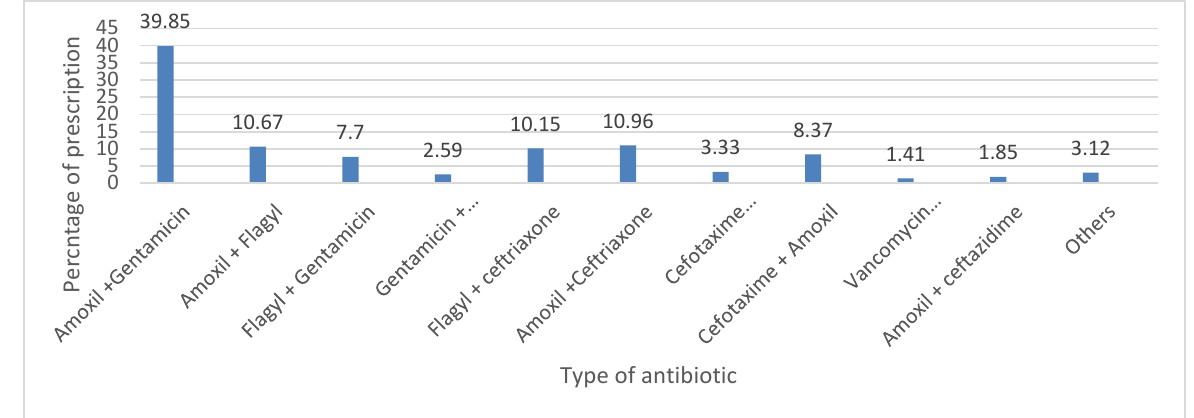
Figure 4: Double antibiotics prescribed in inpatient department (Total 1350).